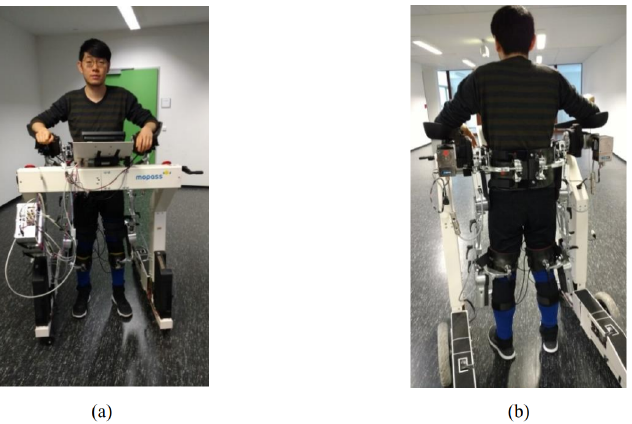
Figure 12. MOPASS gait rehabilitation system from frontal ( a ) and back ( b ) sides